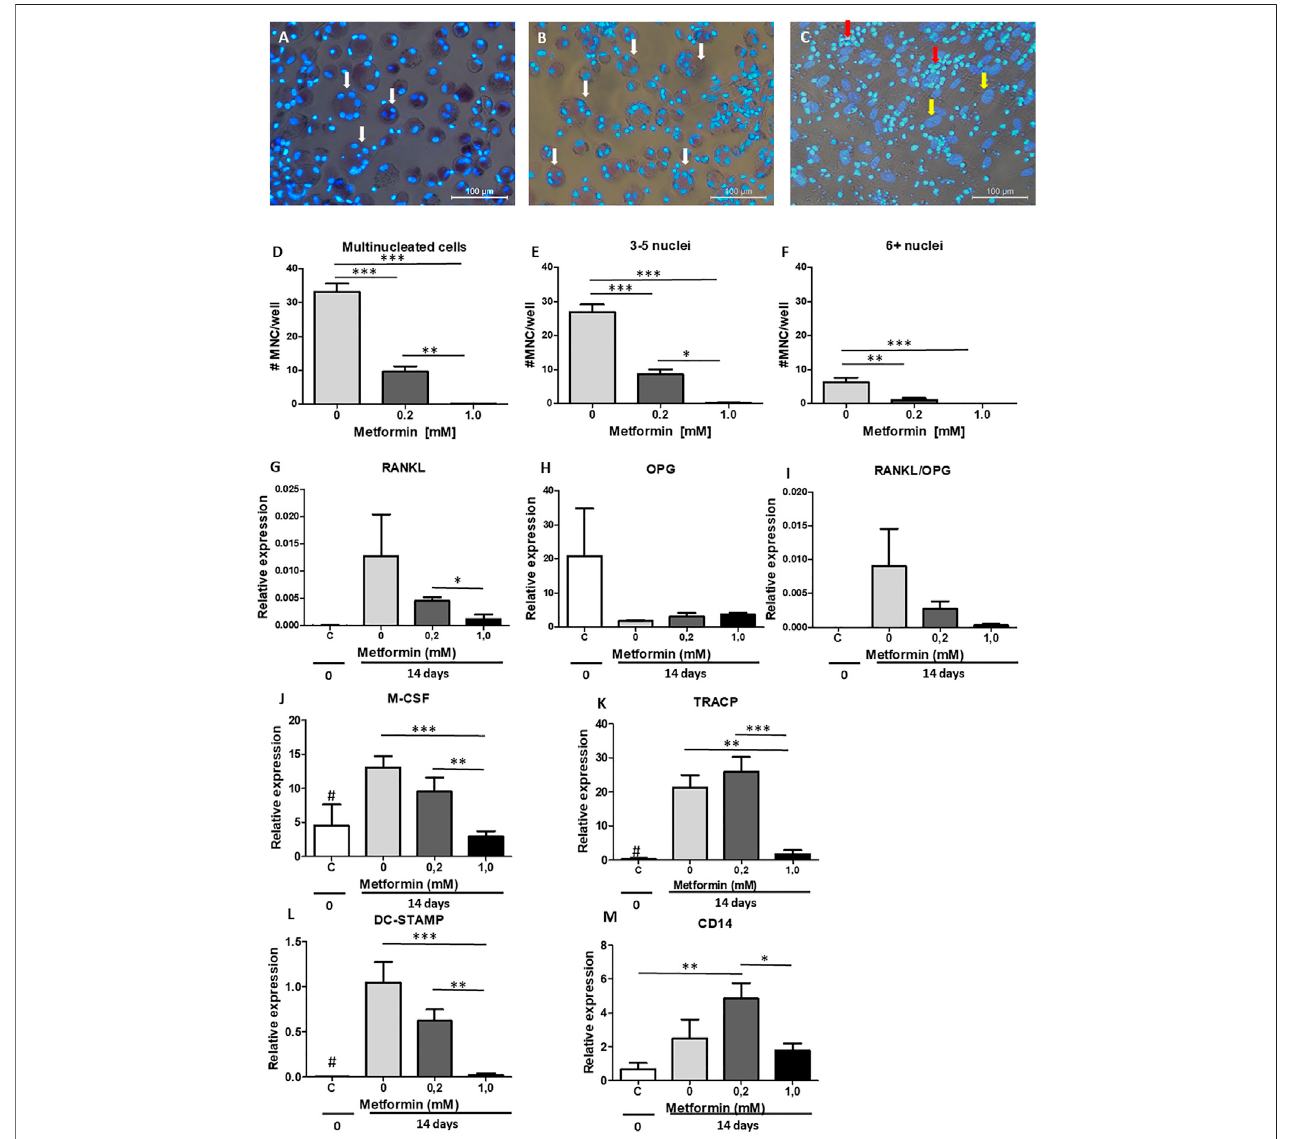
FIGURE 3 | Metformin inhibits periodontal ligament fi broblasts mediated osteoclast formation. PBMC were cultured on periodontal ligament fi broblasts and osteoclast formation was assessed at 21 days after TRAcP staining (A – C) . (A) Control, without metformin, (B) 0.2 mM metformin and (C) 1.0 mM metformin. (D – F) : Inhibition of numbers of multinucleated cells (MNC) formed, both when assessing all multinucleated cells (D , > 2 nuclei ) , small multinucleated cells with 3-5 nuclei (E) , or larger multinucleated cells (F , 6+ nuclei ) . (G – M) : Gene expression at 0 days (C , periodontal ligament fi broblasts without PBMCs ) or 21 days (co-cultures periodontalligament fi broblasts0,0.2and1.0 mMmetformin)ofRANKL (G) ,OPG (H) ,theratioRANKL/OPG (I) ,M-CSF (J) ,TRACP (K) ,DC-STAMP (L) ,andCD14 (M) is inhibited by metformin. All results are from n (cid:2) 6 periodontal ligament fi broblast donors. White arrow in A and B : multinucleated cells, Yellow arrow in C : fi broblast nucleus, Red arrow in C : PBMCs that are not fused and TRACP negative. # in G – I : Control signi fi cantly lower ( p < 0.05) expression than 0 and 0.2 mM metformin in co- cultures.*: p < 0.05; **: p < 0.01;***: p < 0.001.Alldataarefromn (cid:2) 6donors.Osteoclast assay (A – F) wasperformedtwice,obtainingsimilar results,withtwogroupsof six different donors (by LT and KL), results from one experiment are